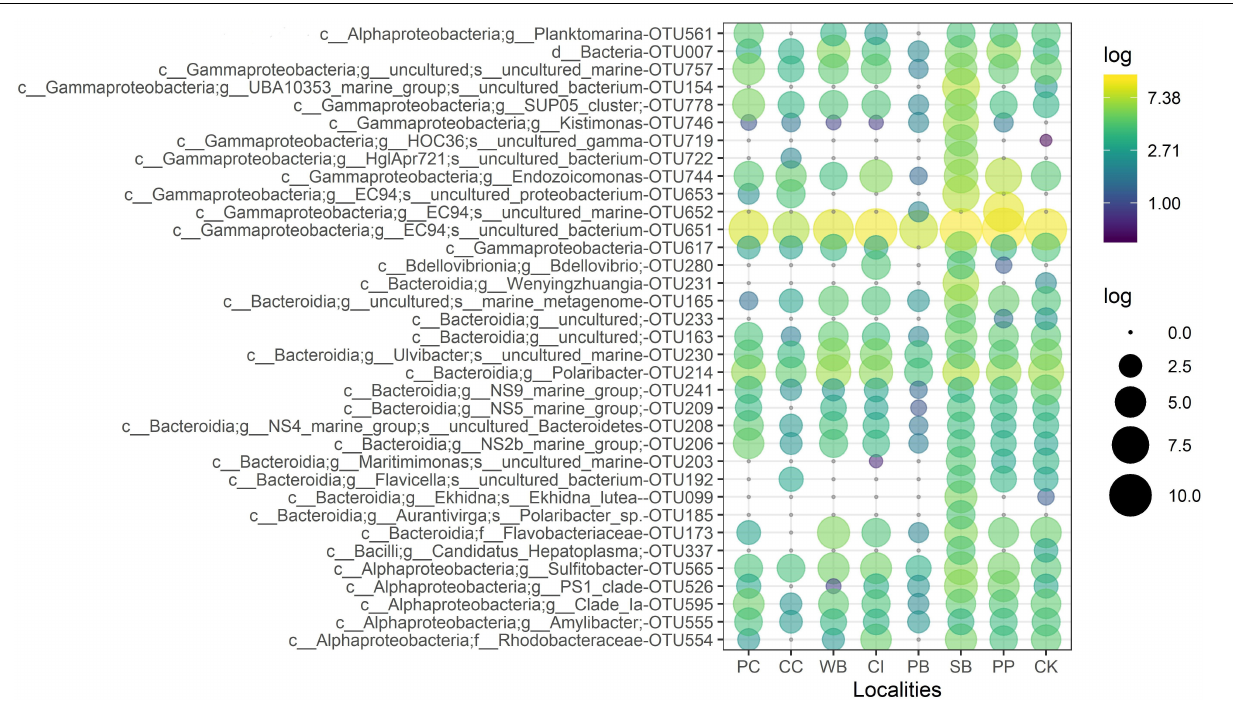
FIGURE 5 | Relative abundance of the 35 most abundant microbial OTUs from M. acerata sampled at different sites along the WAP. The letters before affiliation represent taxonomic levels: d, Domain; c, Class; g, Genus; f, Family; and s, Species. PC, Potter Cove; CC, Cierva Cove; WB, Wilhelmina Bay; CI, Cuverville Island; PB, Paradise Bay; SB, South Bay; PP, Py Point; CK, Cape